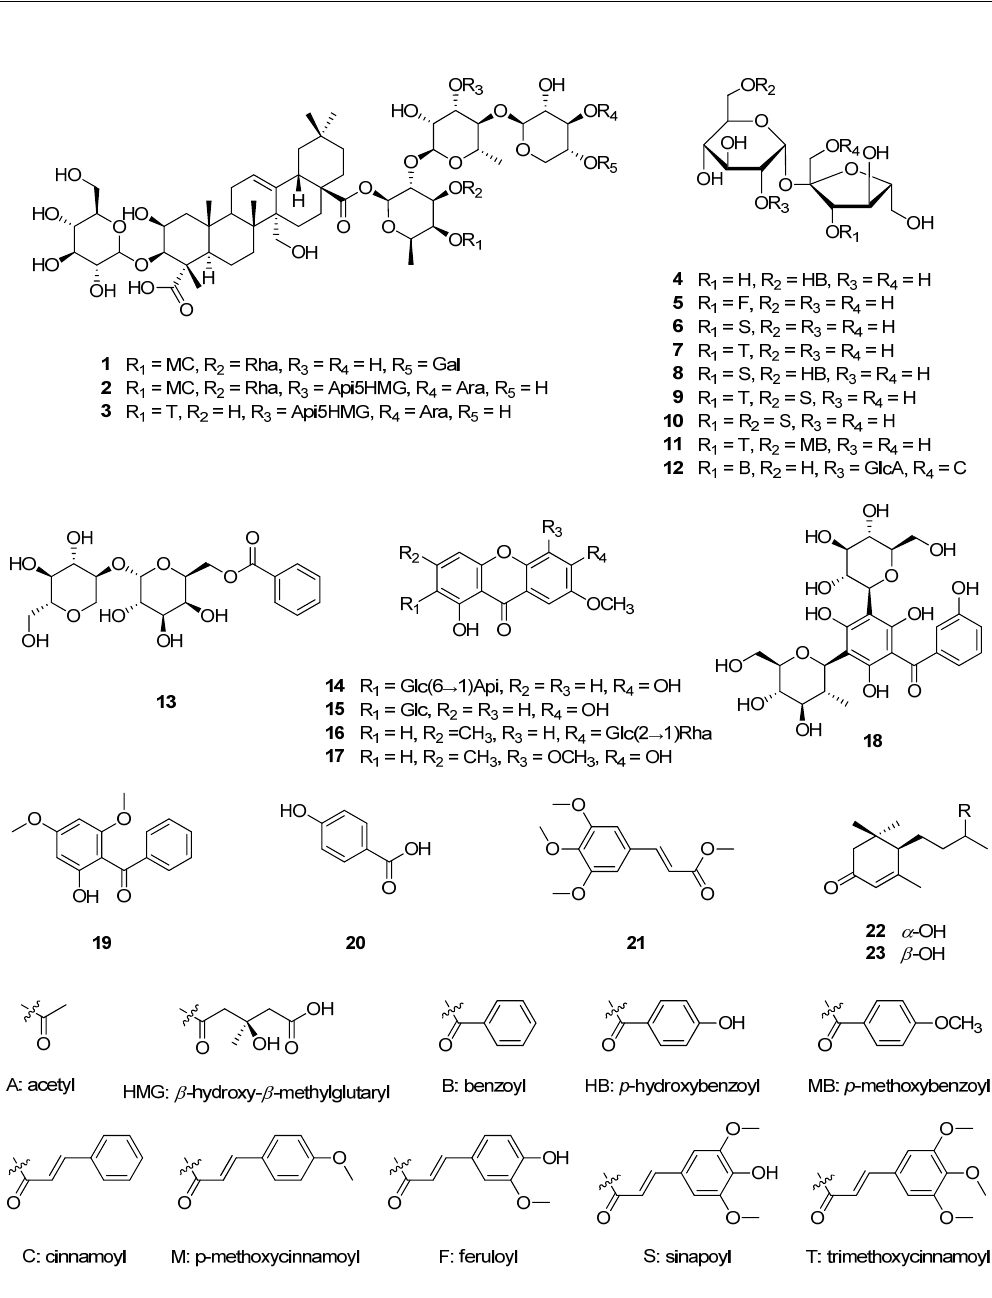
Figure 1. Compounds 1 – 23 isolated from the roots of P . tenuifolia.